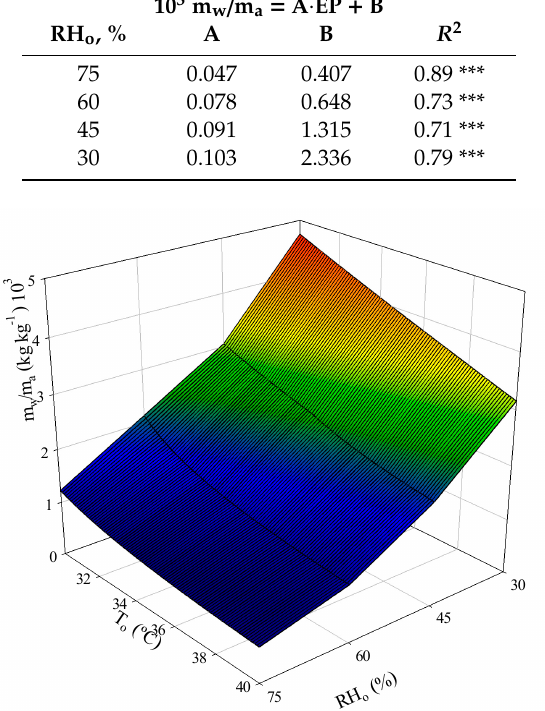
Figure 7. Evolution of the specific water consumption (m w /m a (kg kg − 1 ) 10 3 ) as a function of the exterior temperature (T, °C) and relative humidity (RH, %) values.